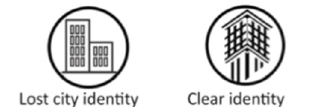
Figure 15. Improve Quality and Discourage Poor Quality of Life.